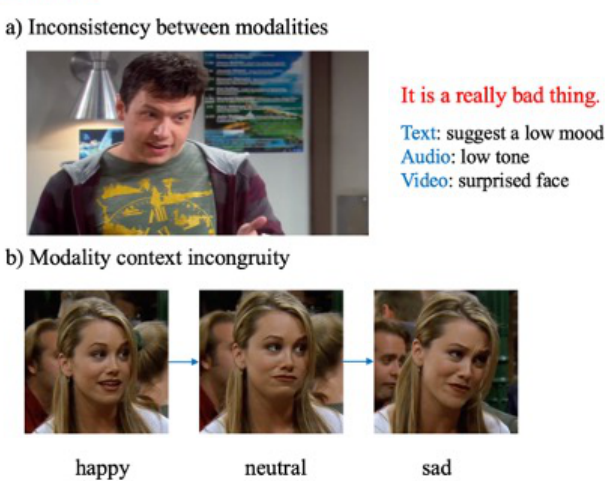
Figure 1. Inconsistency in sarcasm. The text and tone in Figure ( a ) show the same feelings, while the expression shows the opposite. In daily life, a low style usually expresses boredom, while a surprised expression expresses exaggeration and wonder. The feelings expressed by the two are inconsistent, which is a kind of sarcasm. In Figure ( b ), the character’s mood changes from happiness to sadness, indicating an inconsistency of feelings, so this is another expression of